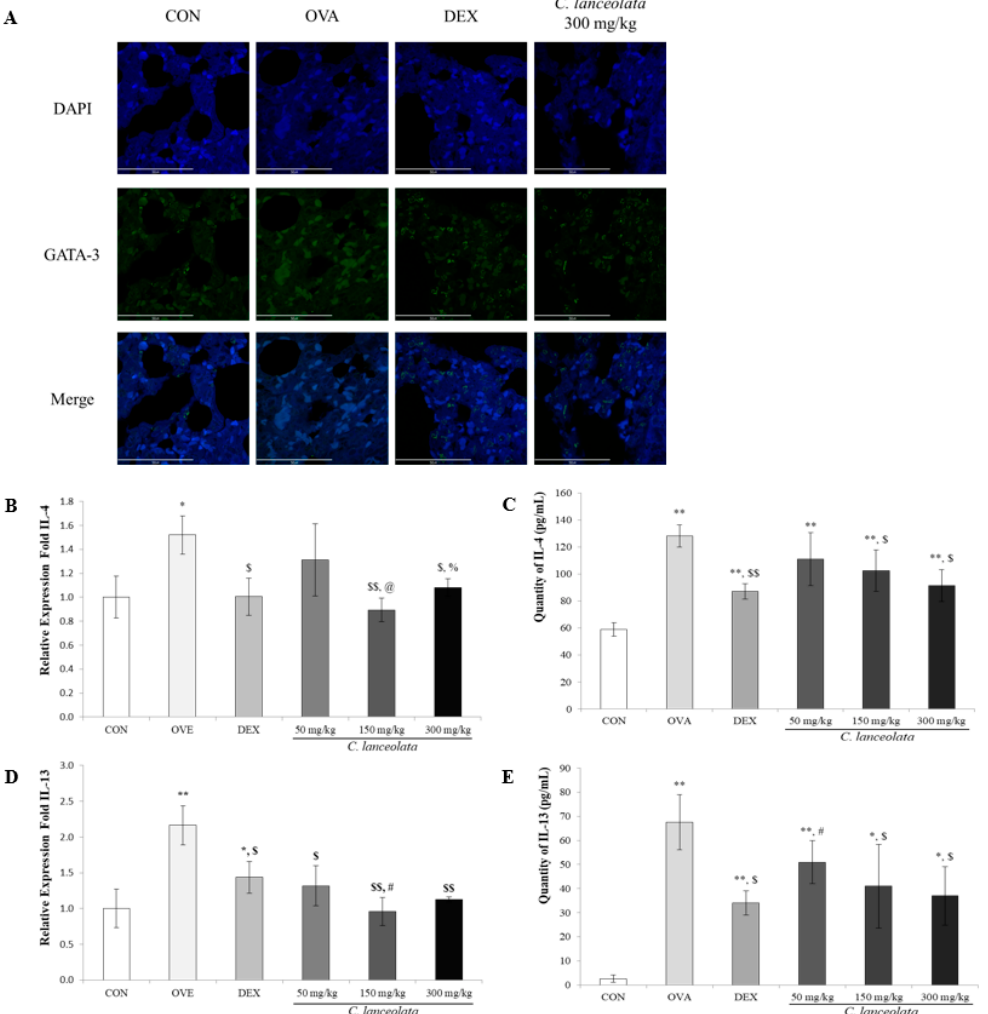
Figure 3. C. laceolata controlled the level of ovalbumin-induced Th2-related cytokines such as IL- 4 and IL-13 by inactivating the Th2 cell transcription factor, GATA-3. ( A ) The expression result of the Th2 cell transcription factor, GATA-3, according to the C. laceolata treatment. In order to release the Th2-related cytokines, GATA-3 should translocate from the cytoplasm to the nucleus to conduct the Th2 cell transcription factor. The released levels of GATA-3 both in the dexamethasone treatment group (DEX) and the 300 mg/kg/day C. laceolata treatment group were higher than that in the ovalbumin treatment group, and that meant that the dexamethasone treatment and C. laceolata treatment prevented ovalbumin-induced GATA-3 activation. Scale bar, 50 µ m; magnification, × 400. CON, vehicle group; OVA, ovalbumin-induced asthma group; DEX, positive control group (1 mg/kg/day dexamethasone with OVA); C. laceolata 300 mg/kg, 300 mg/kg/day C. laceolata